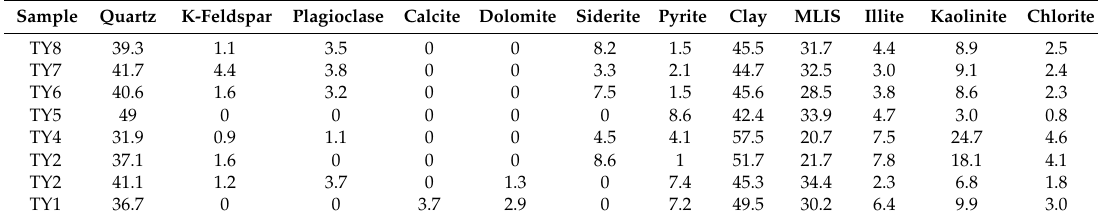
Table 2. Mineral compositions determined by XRD of the Taiyuan marine shale samples. The